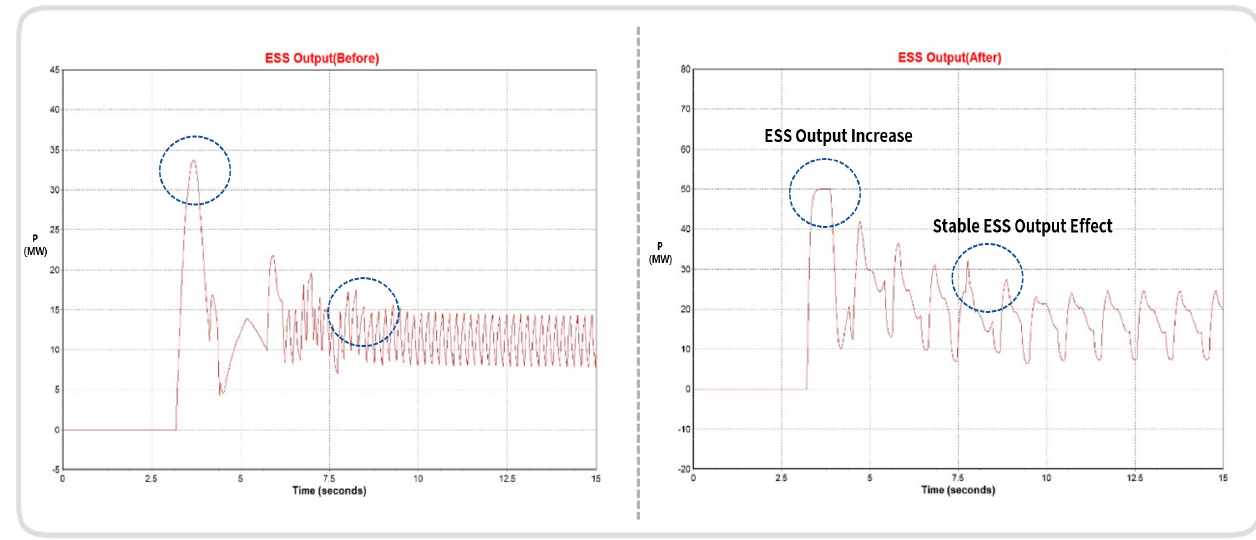
Figure 18. Comparison of ESS output before and after applying optimal parameters.